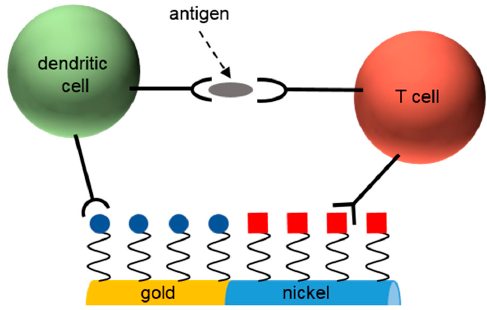
Figure 4. A Ni-Au segmented nanorod acting as bridge between a dendritic cell and a T cell. Both cell types were bound to the nanorod via specific surface functionalization. This resulted in a close vicinity of the dendritic and the T cell. As a result an antigen was presented to the receptor of the T cell. Adapted figure from [132] reprinted with permission from copyright (2013) American Chemical Society.